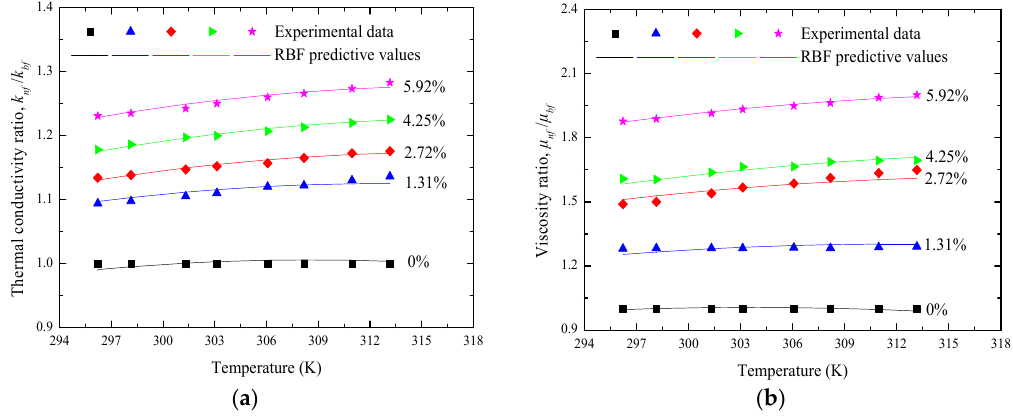
Figure 15. Comparisons of the experimental and RBF predicted results for ( a ) k nf / k bf and ( b ) µ nf / µ bf . Table 5. Performance evaluation of the RBF neural network for the training and testing samples.